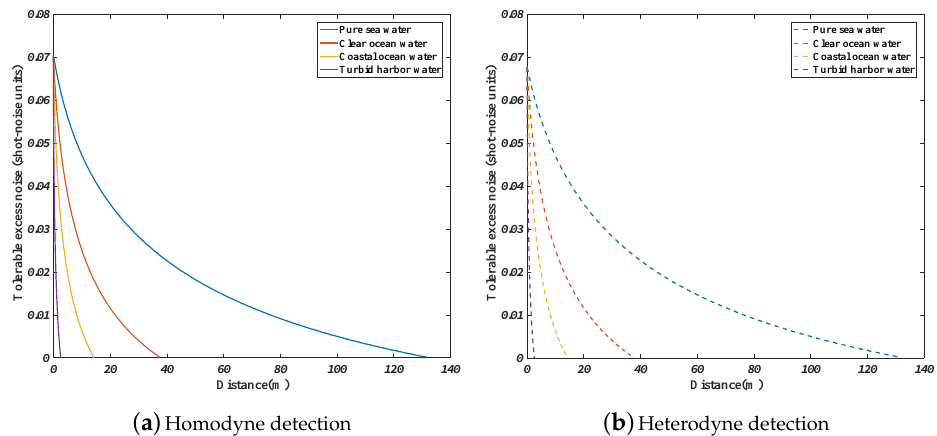
Figure 7. (Color online.) The maximum tolerable excess noise at each distance for four-state protocol. β = 0.9, V A = 0.6, η = 0.6, v el = 0.01.